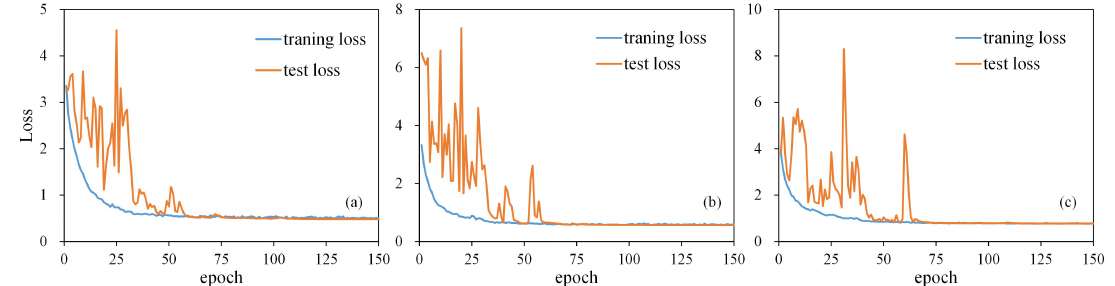
Figure 6. Convergence curves during the fine-tuning process of the Botswana scene: ( a ) SG-CNN-7, ( b ) SG-CNN-8, ( c )